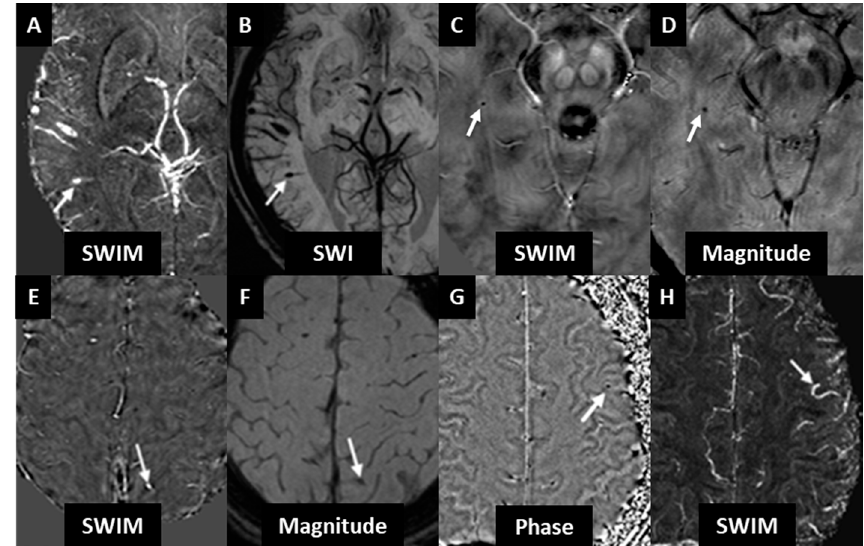
Figure 1. CMB mimics can be differentiated from true CMBs by reviewing their appearance in all SWI modalities simultaneously. ( A , B ) Vascular damage indicated by the white arrow can be differentiated by its connectivity to surrounding veins. The SWI minimum intensity projection (over 5 slices) shows a connectivity of the bleed to a draining vein suggesting an intraluminal source for the CMB possibly a thrombus in this case. ( C , D ) Magnitude images cannot differentiate diamagnetism from paramagnetism ( D ) as indicated by the white arrow. The same region when viewed in the iSWIM reconstruction appears hypointense ( C ) indicating that the CMB candidate is diamagnetic and that the source is likely a calcification and not a CMB. ( E , F ) Potential CMB candidates may be vascular structures as their orientation to the slice and the magnetic field can create phase effects similar to those of a CMB. In the iSWIM reconstruction ( E ) the structure as indicated by the white arrow is shown to have a high paramagnetic susceptibility, however, in the second echo magnitude ( F ) the center of the object lacks clear hypo-intensity indicating it is likely a fast flowing vessel. ( G , H ) Veins which are perpendicular to the slice, such as the vein labeled with the white arrow, can appear as round hypo-intensities and may even show a dipole effect in phase ( G ) if it is near a confluence of two veins. In the iSWIM maximum intensity projection ( H ) clear connectivity to a pial vein can be observed and the signal intensity in phase is seen on the QSM result to be from a continuous vessel.